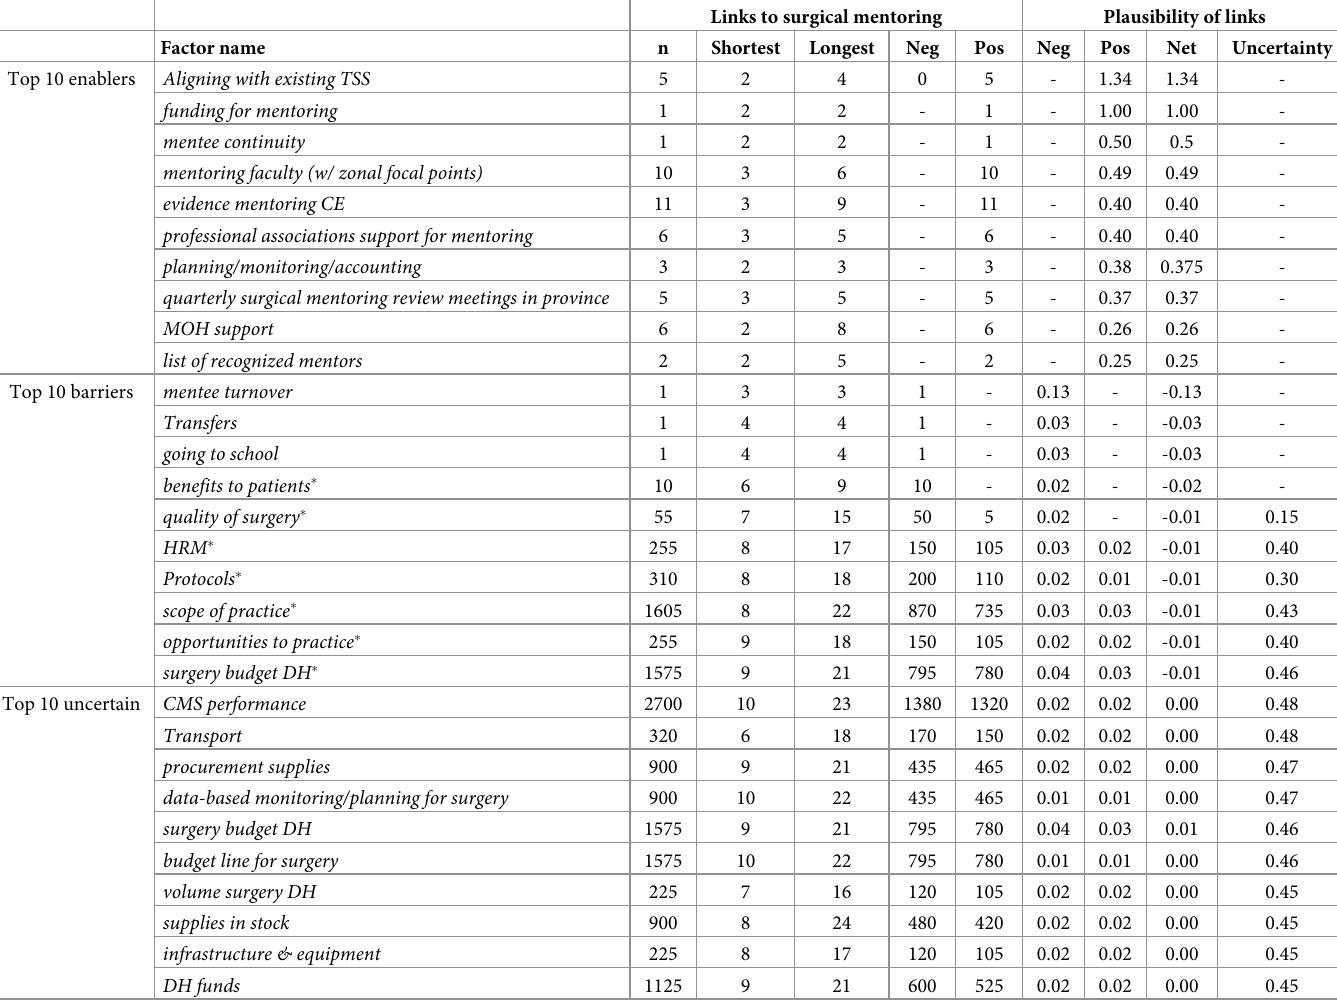
Table 4. Results from the qualitative structural analysis to investigate impact on surgical